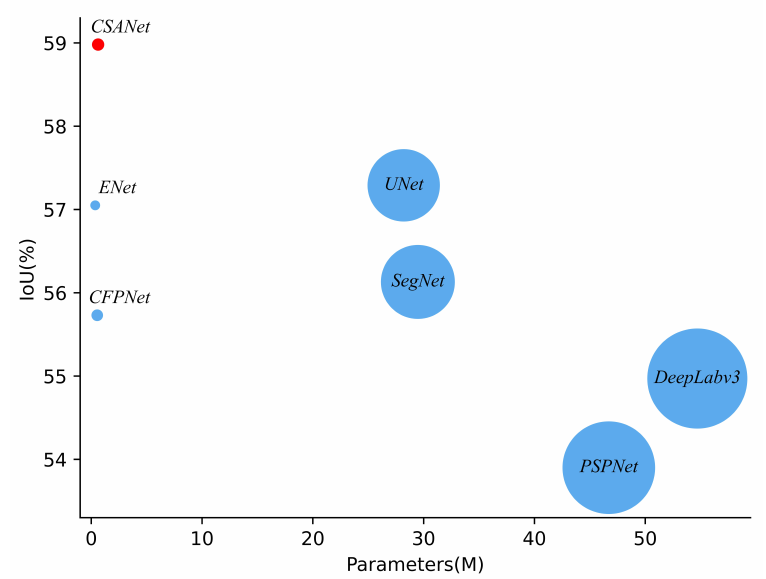
Figure 10. Network parameter volume and IoU